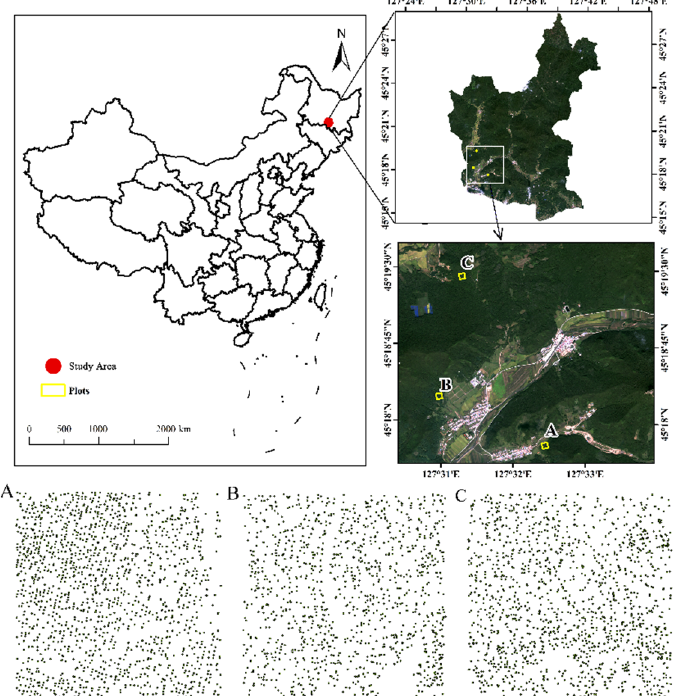
Figure 1. Study area and sample site location. ( A ) the distribution of single trees in the plot of the broadleaf forest; ( B ) the distribution of single trees in the plot of coniferous forest; ( C ) the distribution of single trees in the plot of the coniferous and broadleaf mixed forest.